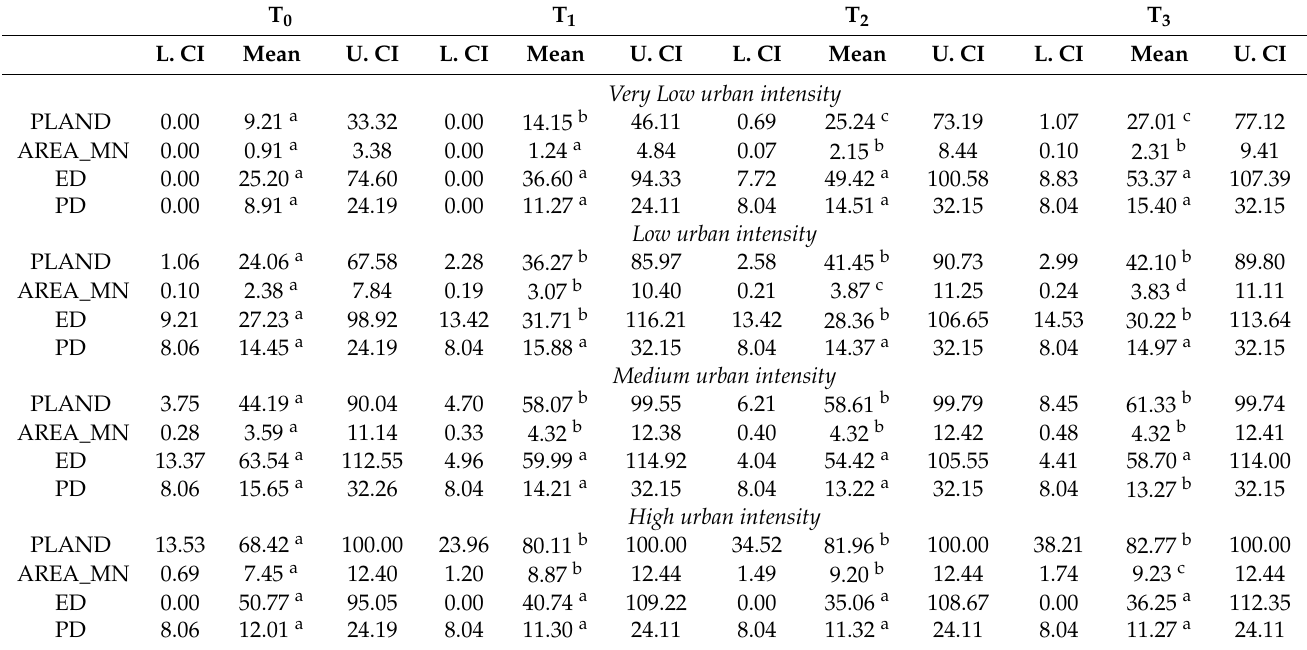
Table 4. Landscape metrics (PLAND, AREA_MN, ED, PD) over time (T 0 , T 1 , T 2 , T 3 ) for the cells labelled at T 0 according to their urban intensity (Very Low, Low, Medium, High). Mean values, upper (U. CI) and lower (L. CI) confidence intervals are reported. a, b, c, d indicate significant differences over time in the mean metric